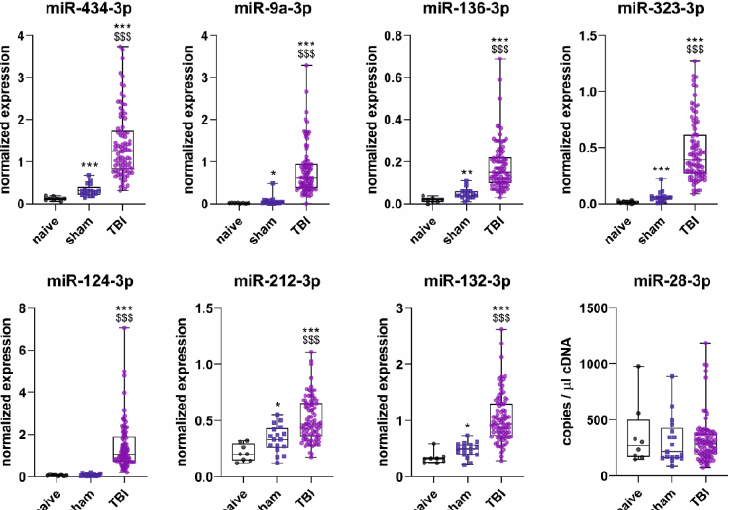
Figure 3. D2 plasma miRNA levels in different animal groups. Box and whisker plots (whiskers: minimum and maximum; box: interquartile range; line: median) showing the normalized expression levels of 7 validated miRNAs (miR-434-3p, miR-9a-3p, miR-136-3p, miR-323-3p, miR-124-3p, miR-212- 3p, and miR-132-3p) measured by droplet digital PCR (ddPCR). MiR-28-3p was used as endogenous reference for normalization (target concentration/reference concentration). All 7 miRNAs were upregulated in the TBI group ( n = 90) compared with naïve ( n = 8) or sham-operated ( n = 17) rats. Of 7 miRNAs, 6 (all except miR-124-3p) were upregulated in the sham group compared with the naïve group. The levels of the endogenous control miR-28-3p did not differ between the animal groups. Statistical significance: *, p < 0.05; **, p < 0.01; ***, p < 0.001 (compared with naïve); $$$, p <